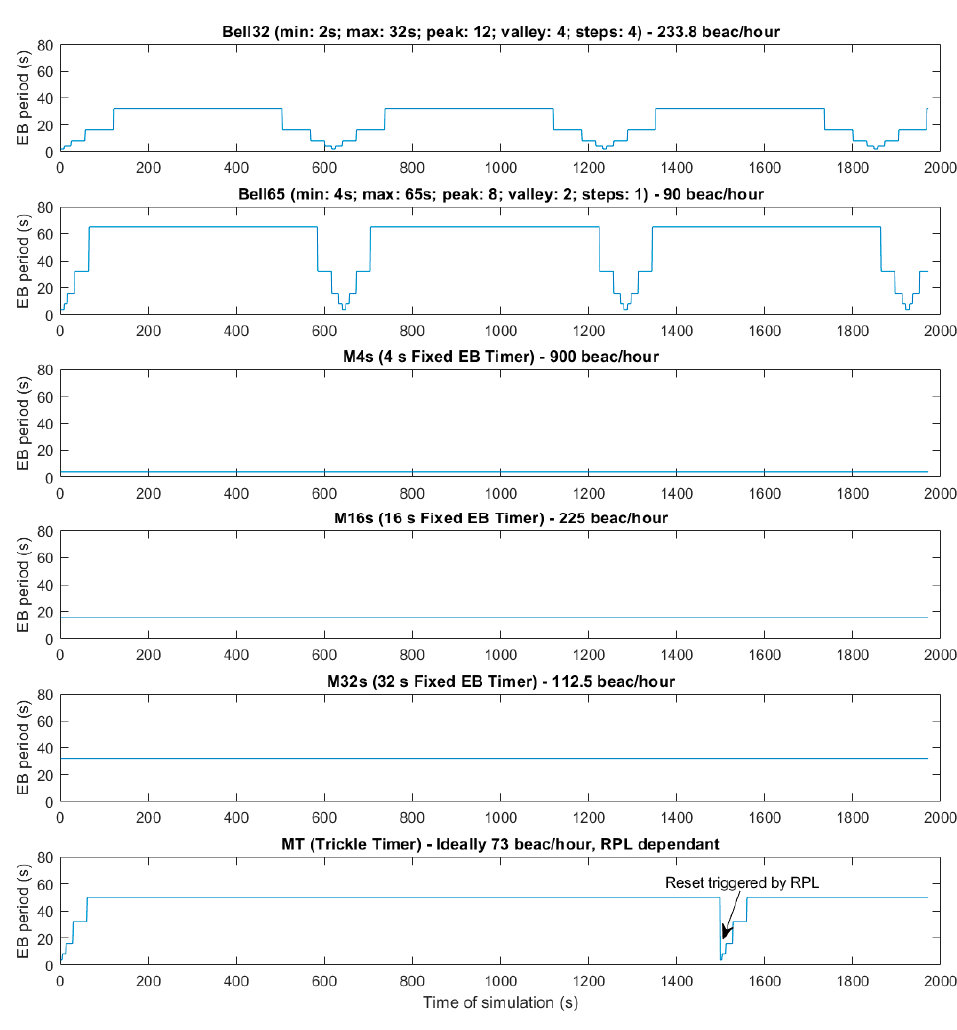
Figure 17. Comparison of the different simulated configurations in beacons per hour.